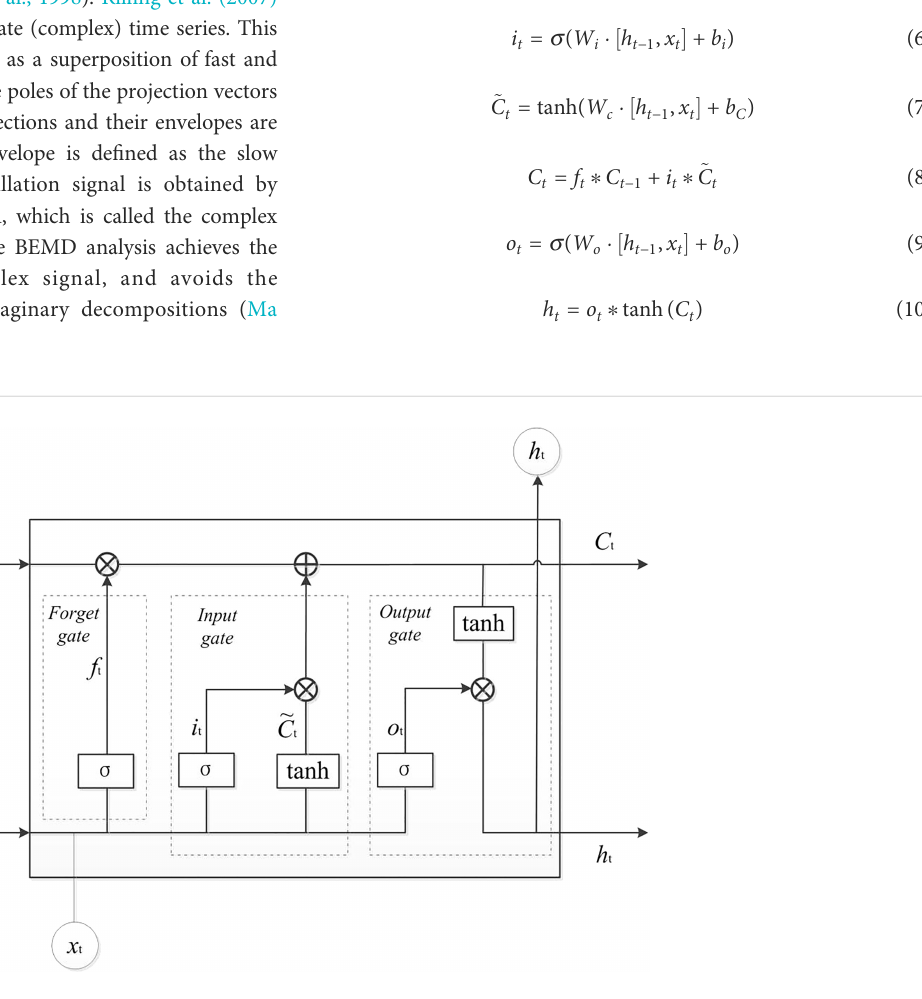
FIGURE 2 Structure of an LSTM